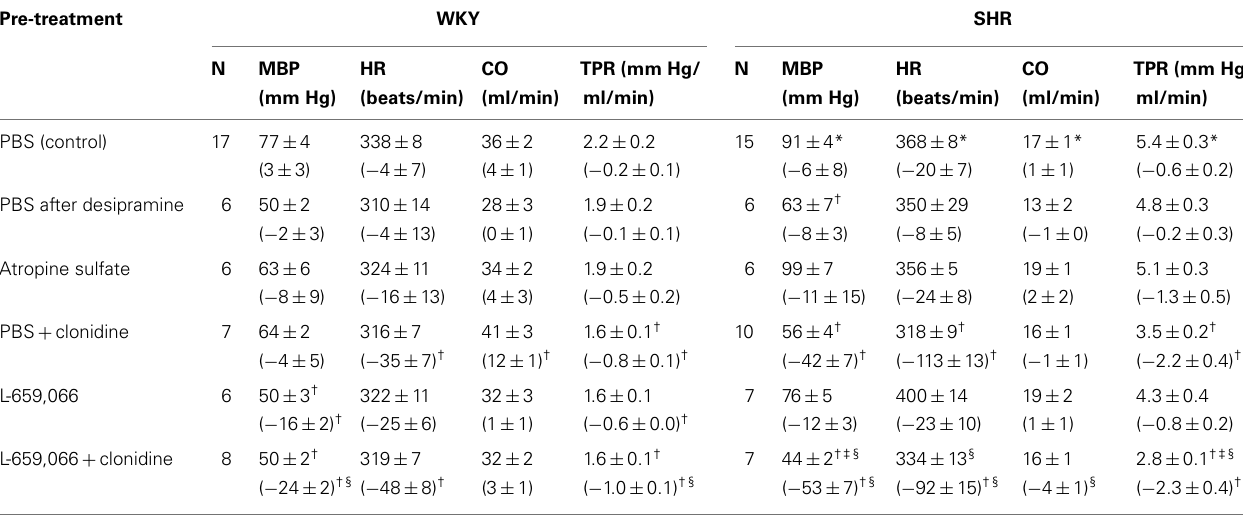
Table 1 | Cardiovascular baselines prior to tyramine and, in parenthesis, the response to pre-treatment.